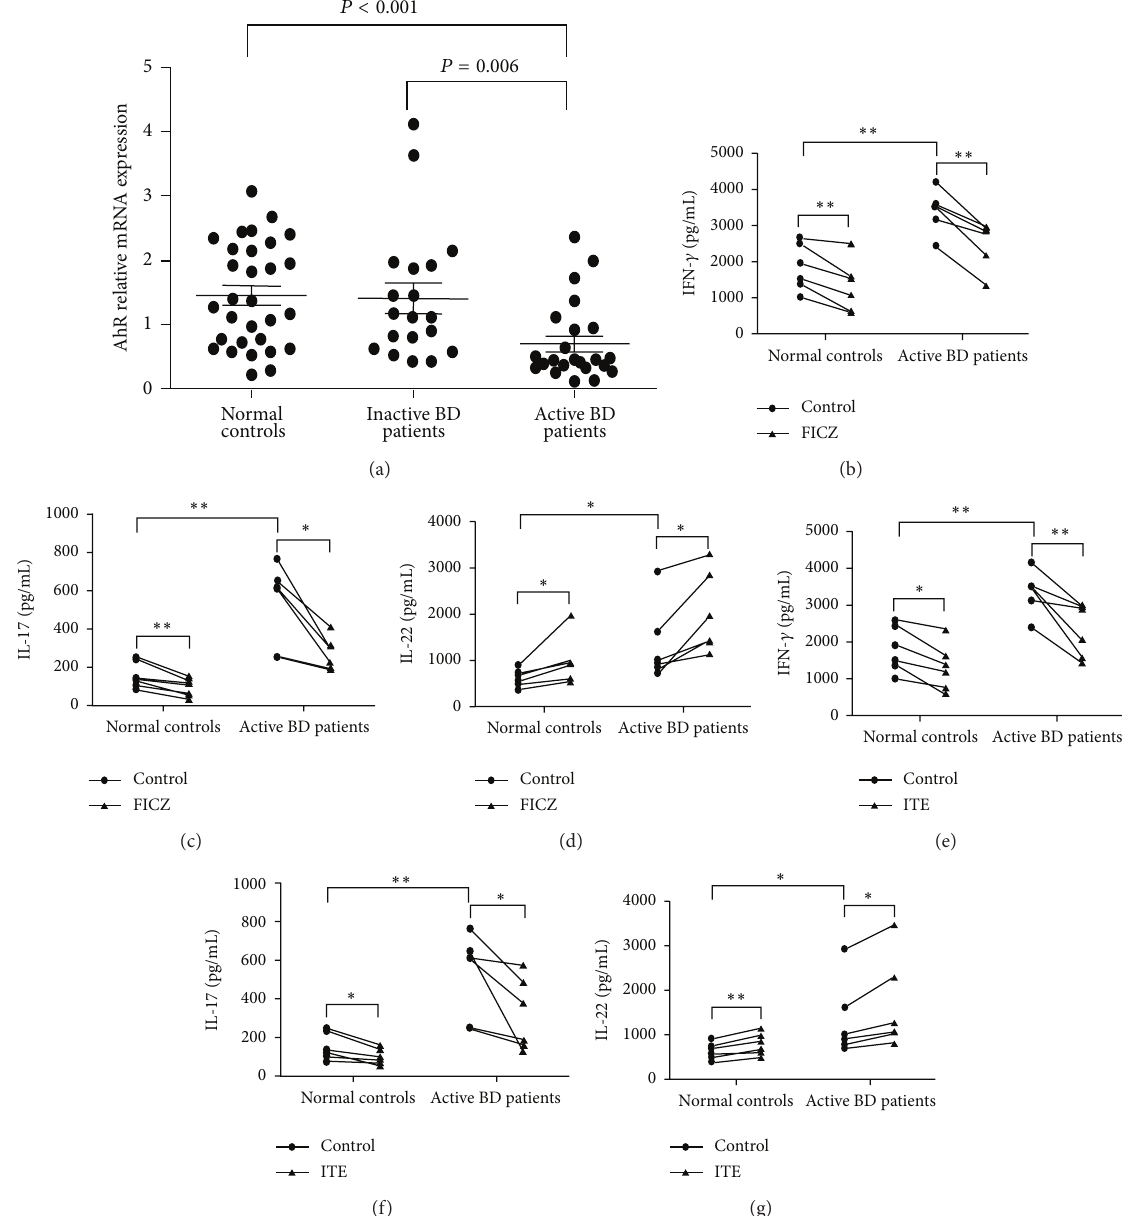
Figure 1: AhR mRNA expression is decreased in active BD patients and AhR activation by FICZ and ITE inhibits IFN- 𝛾 and IL-17 and induces IL-22 production by PBMCs. (a) AhR mRNA was evaluated in PBMCs from active BD patients ( 𝑛 = 23 ), inactive BD patients ( 𝑛 = 19 ), and normal controls ( 𝑛 = 30 ) by real-time PCR and normalized to 𝛽 -actin. The Kruskal-Wallis test and Mann-Whitney test were used to analyze the statistical difference between the various groups. Data are expressed as mean ± s.e.m. (b–g) PBMCs from active BD patients ( 𝑛 = 6 ) and normal controls ( 𝑛 = 6 ) were stimulated with anti-CD3/CD28 in the presence or absence of FICZ (100 nmol/L) or ITE (100nmol/L) for 3 days. The supernatants were harvested for detection of IFN- 𝛾 (b and e), IL-17 (c and f), and IL-22 (d and g) by ELISA. Paired-sample t test or Wilcoxon’s matched-pairs test for related samples and Independent-Sample t test for independent samples were used for statistical analyses. ∗ 𝑃 < 0.05 , ∗∗ 𝑃 < 0.01